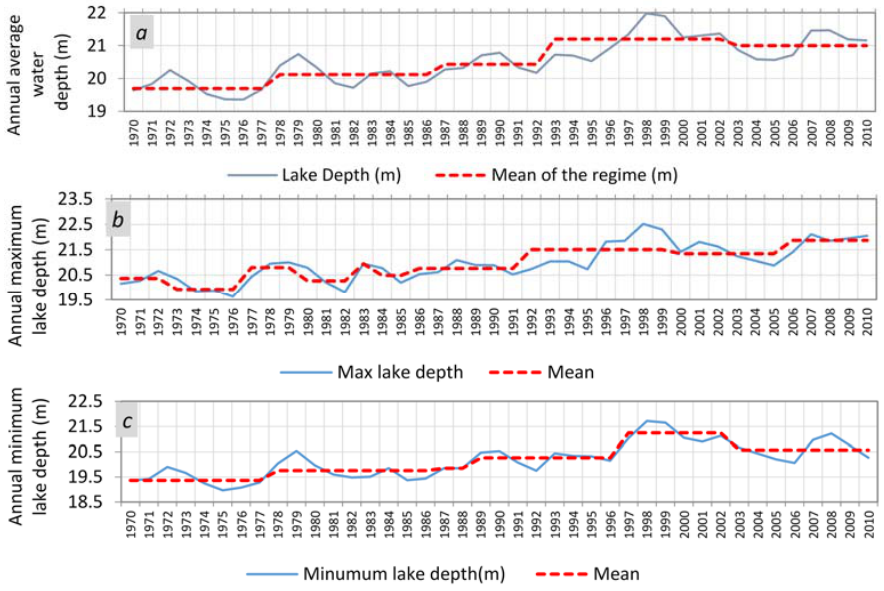
Figure 4. Sequential regime-shifts in annual lake levels ( a ) average; ( b ) maximum and ( c ) minimum.